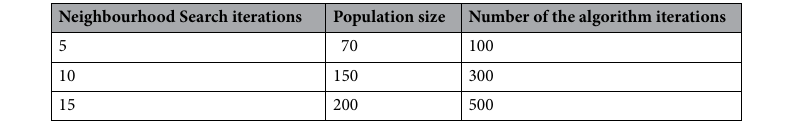
Table 1. Whale algorithm values in three levels.